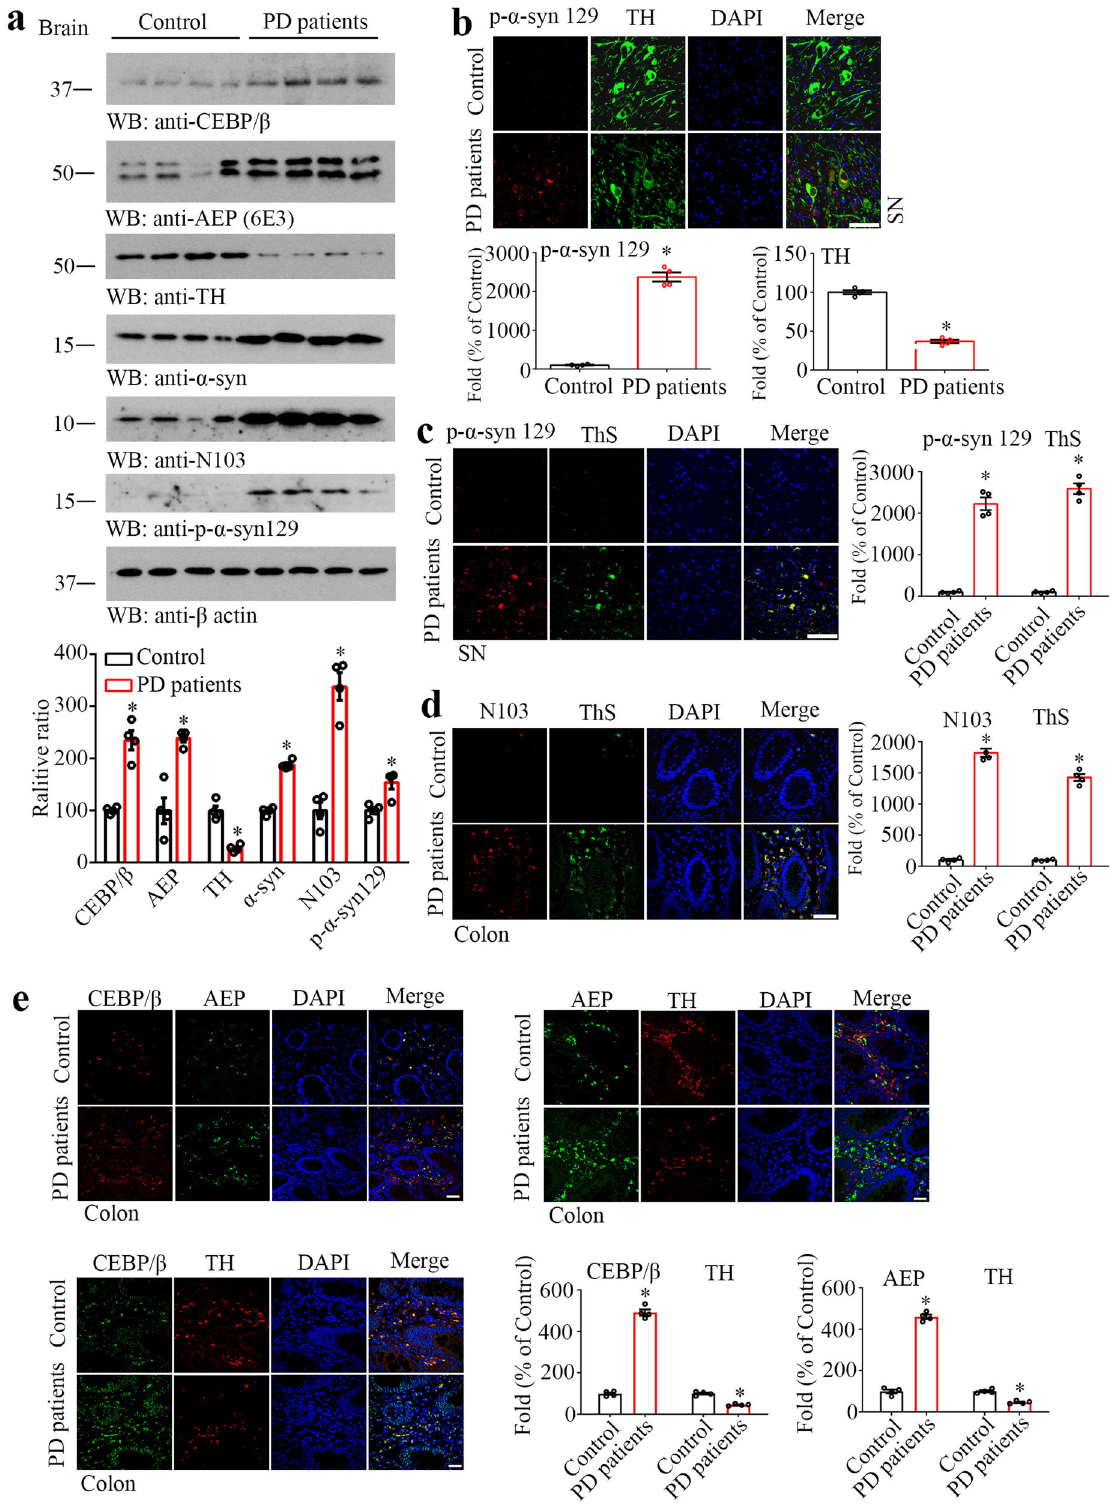
Fig. 7 C/EBP β /AEP signaling is upregulated in PD patient brain and gut. a Western blot and the quanti fi cation showing C/EBP β , AEP, TH, and α -Syn expressing and processing in PD patients and Control. ( n = 4 per group, * P < 0.05 vs Control, Student ’ s t -test, two-tailed). Immuno fl uorescent co-staining of p- α -Syn 129 and TH ( b ) and co-staining of p- α -Syn 129 and ThS ( c ) in SN of PD patients and Control. Quanti fi cation of the immunostaining ( n = 4 per group, * P < 0.05 vs Control, Student ’ s t -test, two-tailed). Scale bar, 100 μ m. Immuno fl uorescent co-staining of N103 and ThS ( d ) and co-staining of CEBP/ β and AEP, CEBP/ β and TH, AEP, and TH ( e ) in the colon of PD patients and healthy control (human biopsy samples with the mucosal/submucosal layer). Quanti fi cation of the immunostaining ( n = 4 per group, * P < 0.05 vs Control, Student ’ s t -test, two-tailed). Scale bar, 50 μ